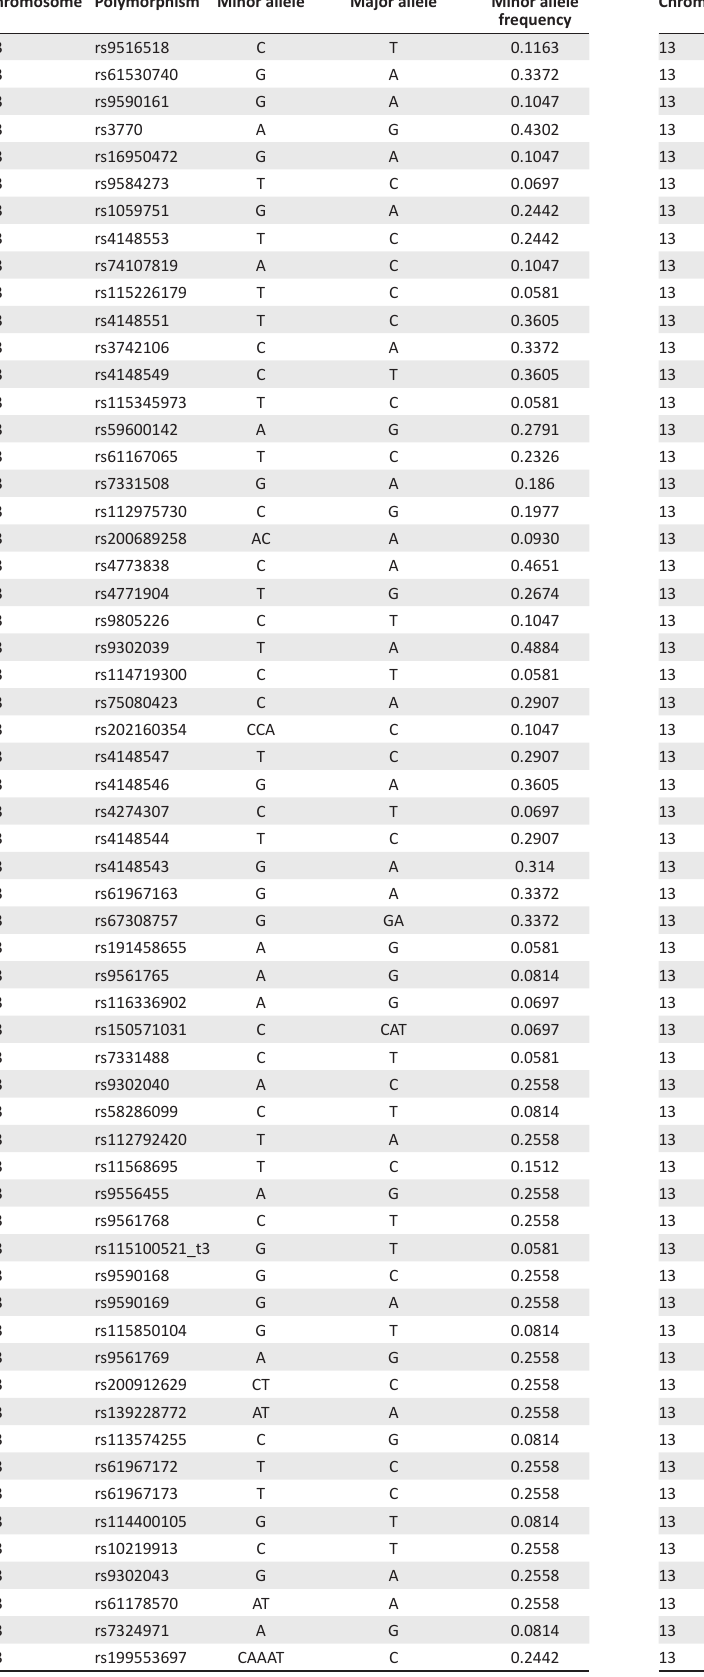
Table 1-A1 continues on the next page →Table 1-A1 continues in the next column